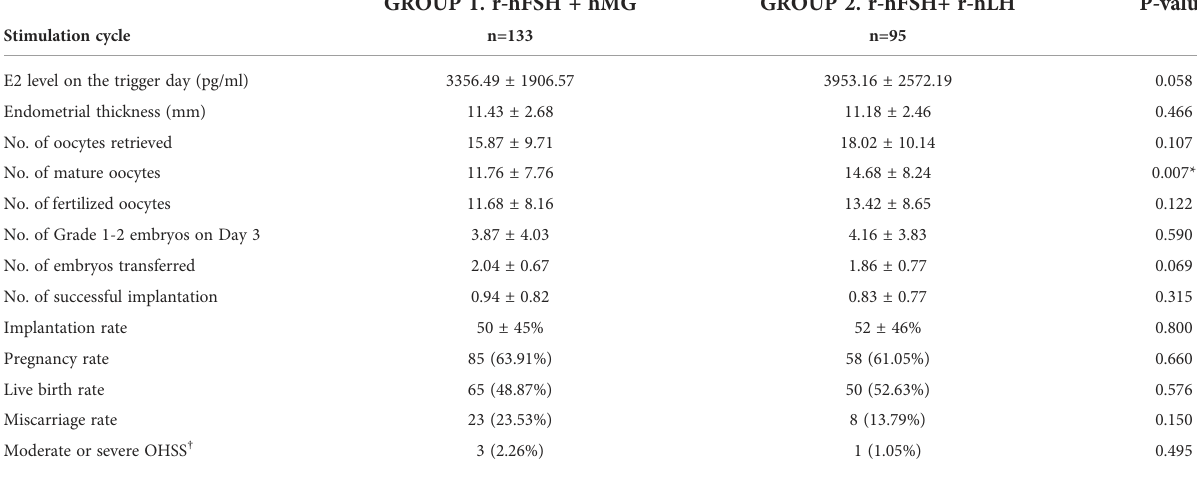
TABLE 5 Outcomes of 1 st FET